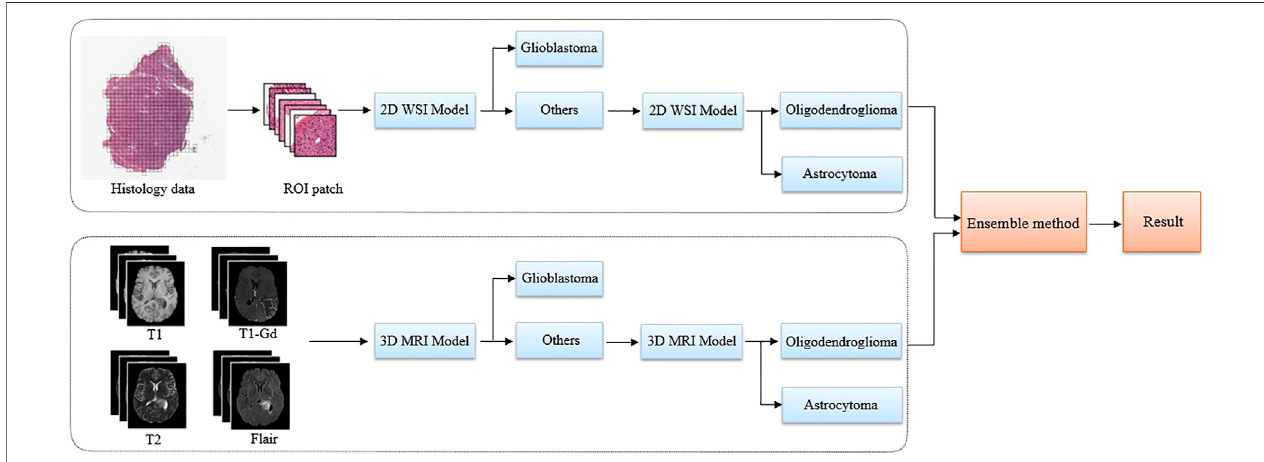
FIGURE 2 | The proposed pipeline using multi-modality data to classify glioma subtypes. A two-stage classi fi cation strategy is applied to both the 2D pathology (WSI)and3DMRIimages.Theglioblastomawithmoreseriousanatomyrepresentationisdetectedinthe fi rststep.Then,inthesecondstep,ouralgorithmfocusesonthe classi fi cation of astrocytoma and